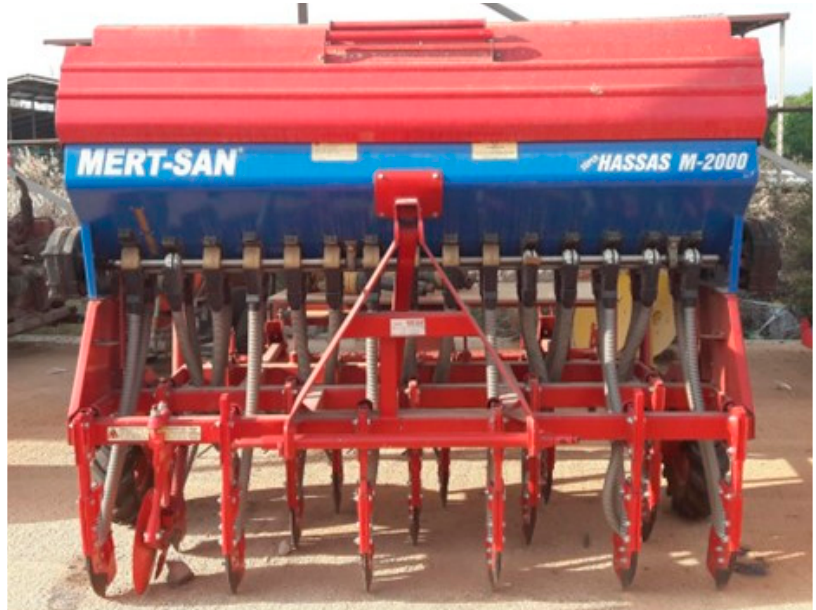
Figure 4. A high-speed camera was positioned across the seed tube at a distance of 400 mm to record the seed flow.